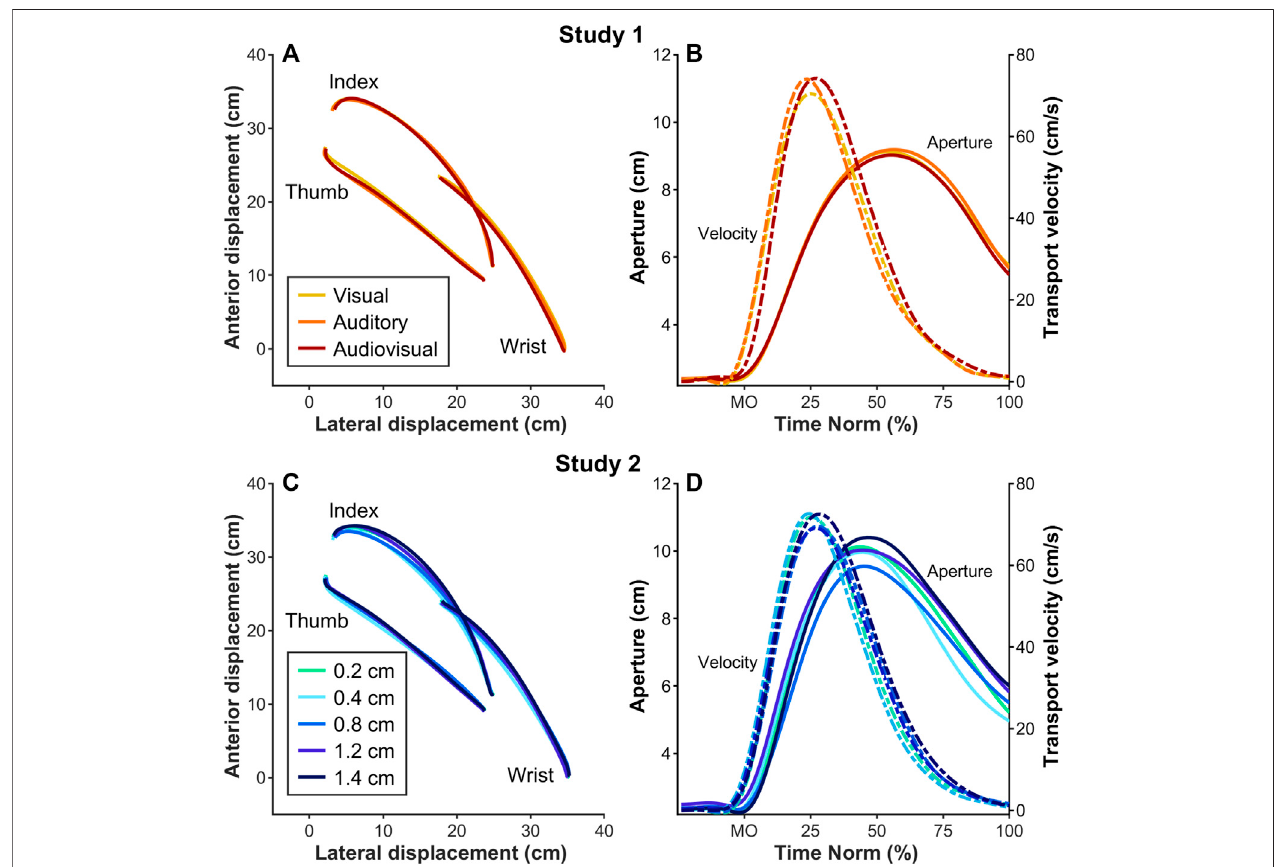
FIGURE 2 | Mean trajectories for a representative participant showing reach-to-grasp kinematics for different sensory feedback and collider size. Study 1. (A) Markertrajectoriesforthewrist,thumb,andindex fi ngeracrossdifferentconditionsofsensoryfeedback. (B) Time-normalizedaperture(solidlines)andtransportvelocity (dashed-dotted lines) pro fi les across different conditions of sensory feedback. Study 2. (C) Marker trajectories for the wrist, thumb, and index fi nger across different collider sizes. (D) Time-normalized aperture (solid lines) and transport velocity (dash-dotted lines) pro fi les across different collider sizes.